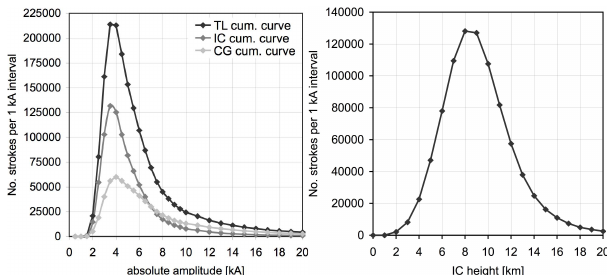
Fig. 2. Schematic illustration of the method used to track ec-TRAM cells from one time step to the next. Identified lightning cells and their tracks are drawn in light grey, radar cells and their identi- fied tracks in dark grey. The tracked ec-TRAM cell is outlined with dashed, black contours. The final ec-TRAM cell track is drawn in a full and dismissed tracks in dashed line styles.